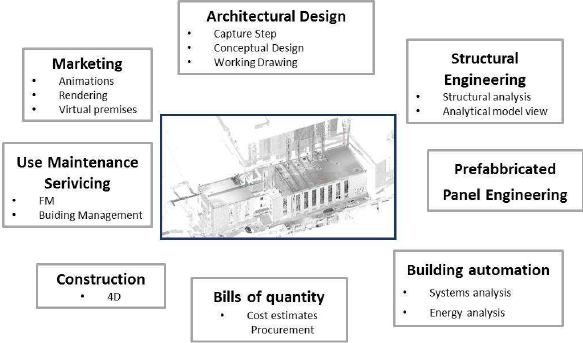
Figure 2. Organization of the building